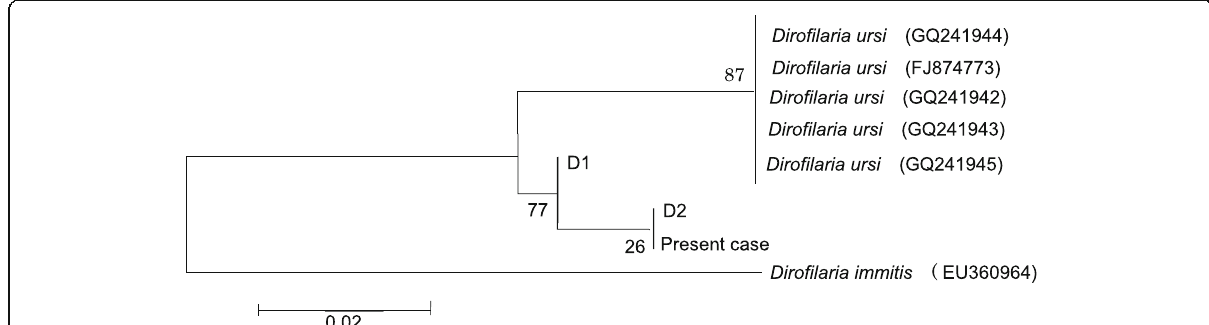
Fig. 4 Phylogenetic analysis of Dirofilaria species based on 5S rRNA sequences (90 bp). Nucleotide sequences were aligned using the Genetyx ver 11 and CLC Sequence Viewer 6 software. Phylogenetic analyses were conducted using the Mega 6 software. Genetic relationships were inferred by the neighbor-joining (NJ) method. D1 and D2 means Dirofilaria ursi worms collected from Japanese bears in Gifu Prefecture in the middle part of